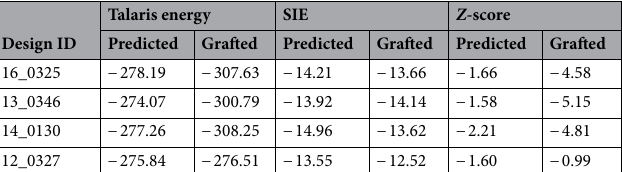
Table 4. Changes in score with variation in loop conformation and environment for the conformation with the best Talaris